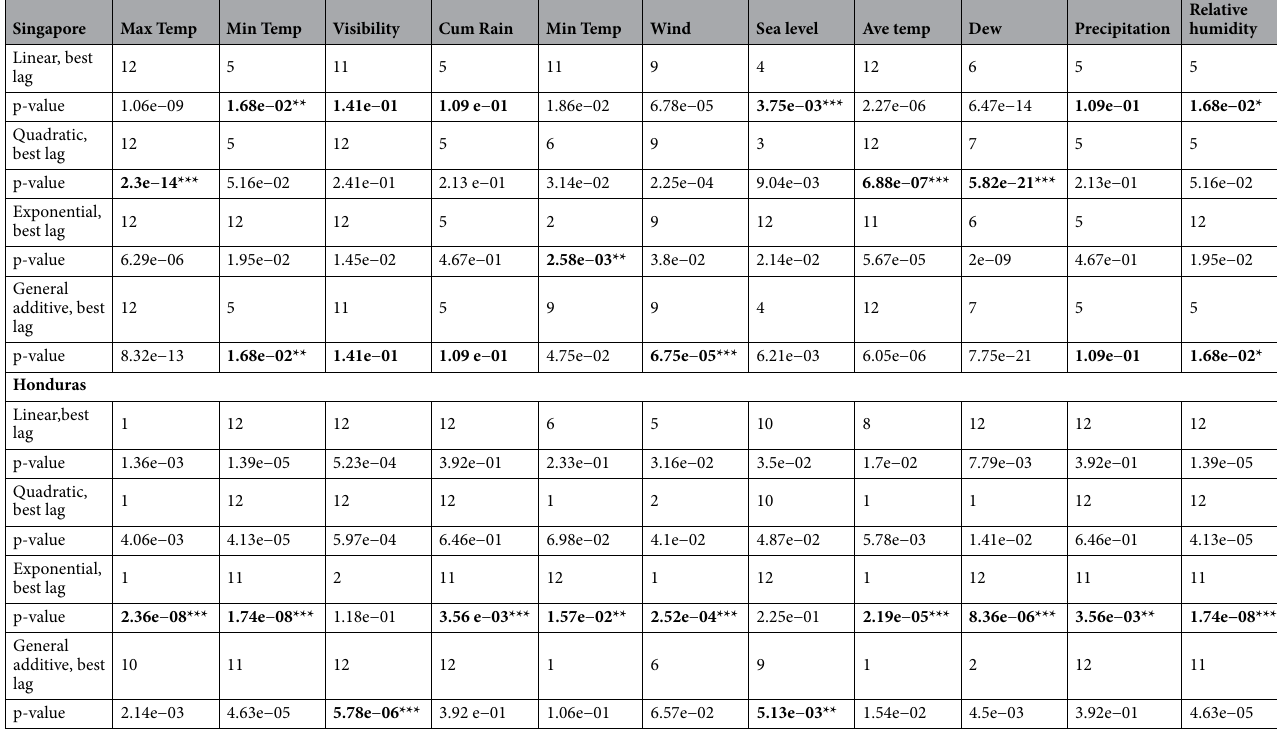
Table 6. Weekly climate correlation results with reported case data in both countries. Bold values represent the highest significance as a predictor for each variable in each country. Lag is in weeks *, < 0.05; **, <